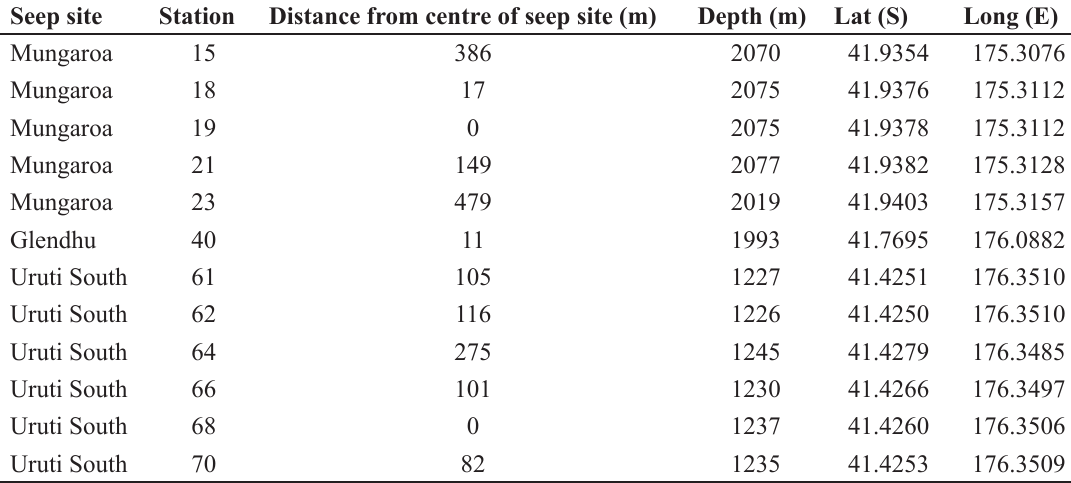
Table 1. Details of cold seep sites and sampling stations (NIWA voyage TAN1904). Only stations from which nematode specimens are described in the present study are